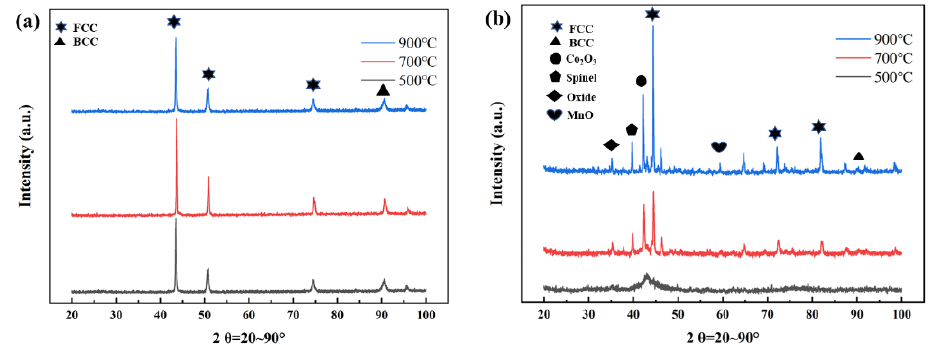
Figure 4. XRD patterns of CoCrFeNiMn high-entropy alloy coatings prepared by CS and HVOF after heat treatment at different temperatures. ( a ) CS coating; ( b ) HOVF